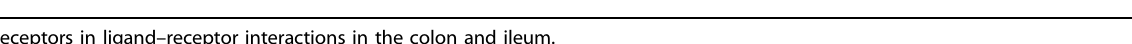
Table 2. Receptors in ligand – receptor interactions in the colon and ileum.